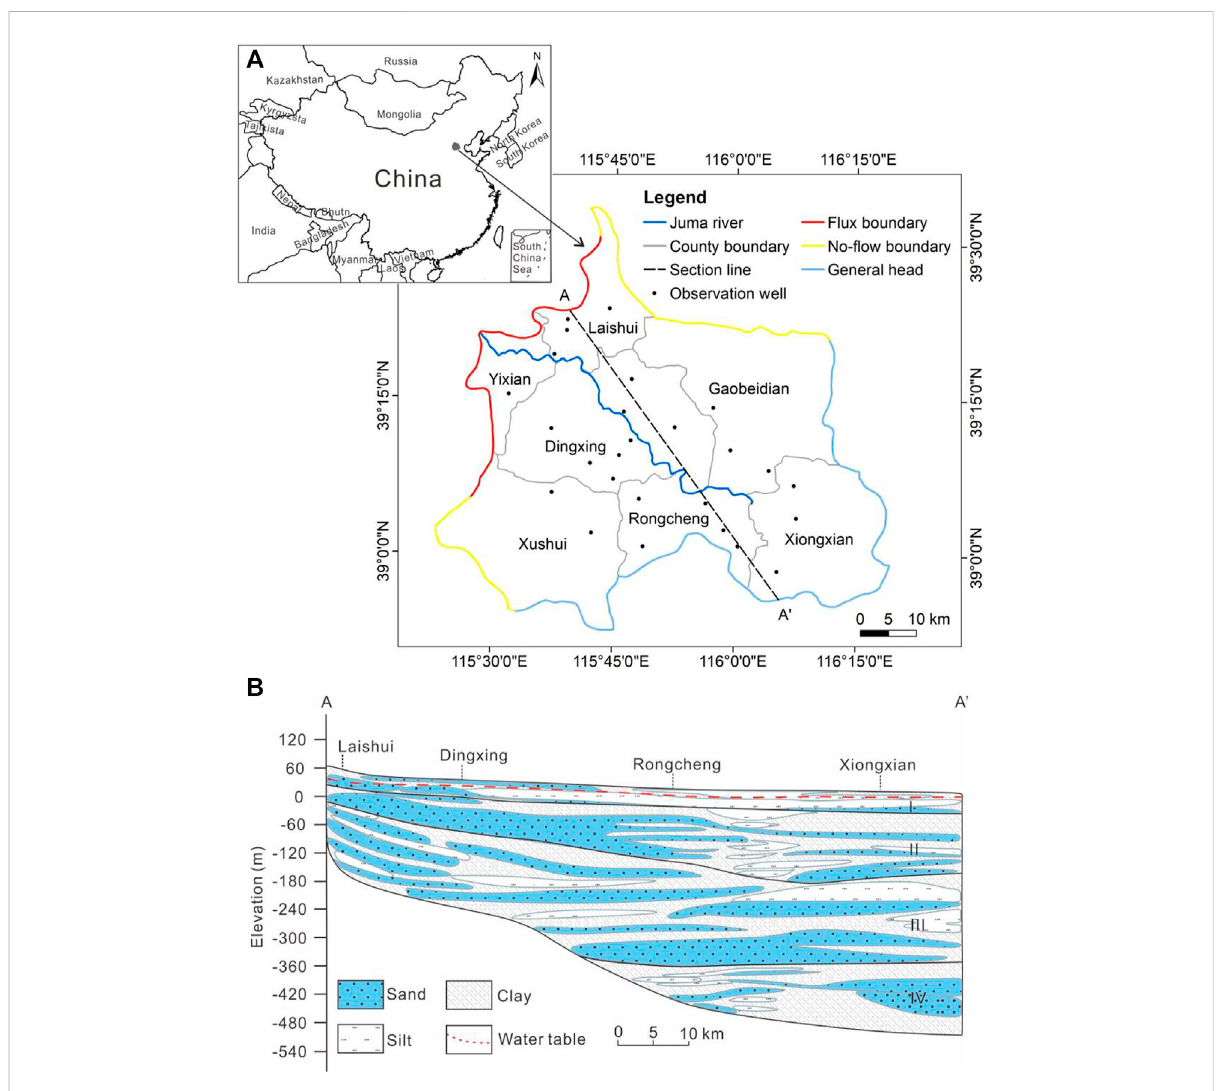
FIGURE 1 (A) Location and model boundaries of the study area; (B) hydrogeological section of the study